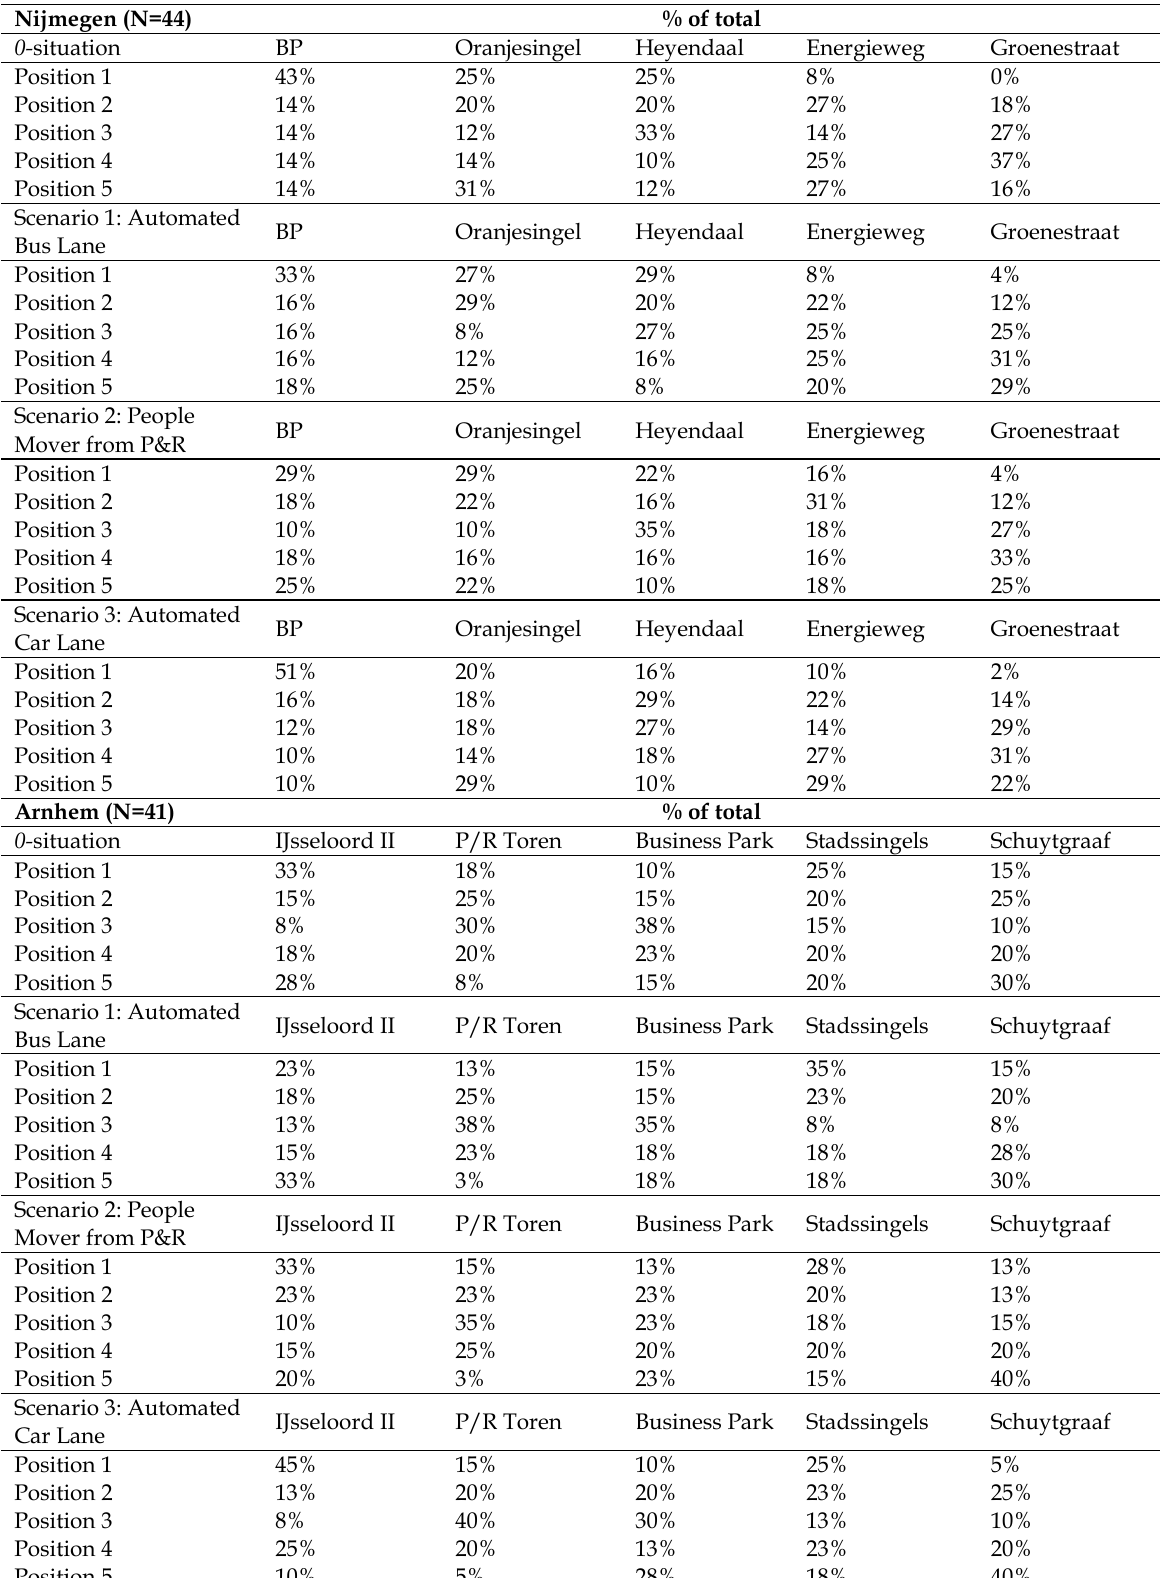
Table 7. Frequency of ranking office-locations in Nijmegen and Arnhem Nijmegen